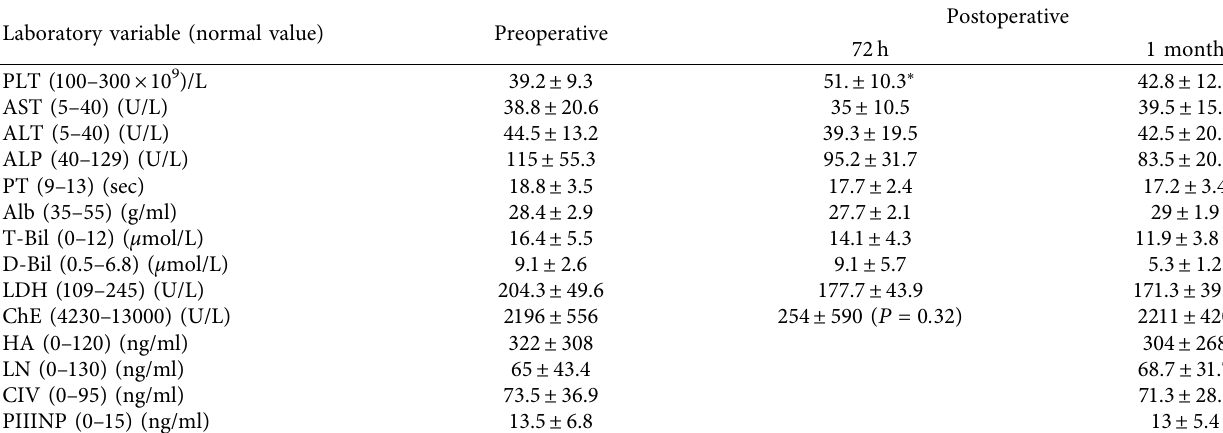
Table 2: Blood test of preoperative and postoperative of liver resection in 6